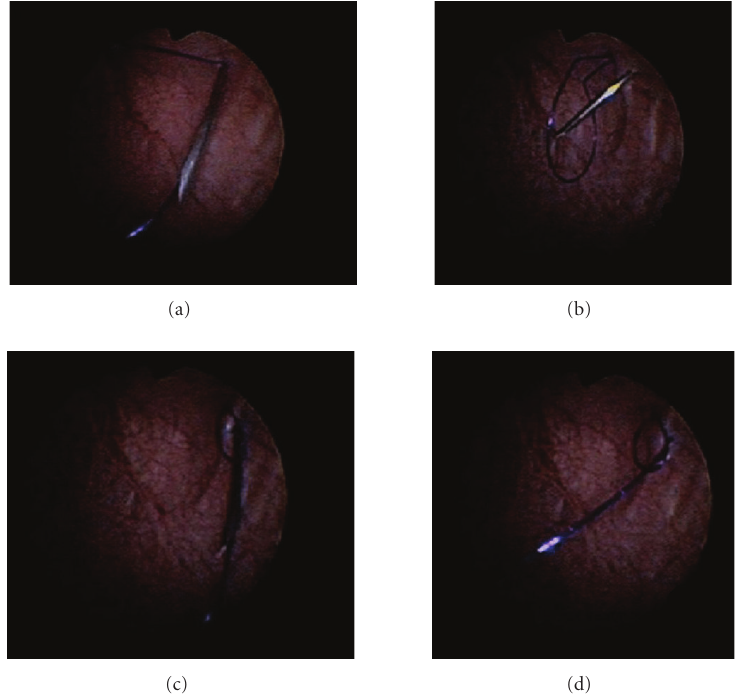
Figure 2: (a) Spinal needle has pushed suture into bladder creating pulling loop. (b) Spinal needle passed through pulling loop via an adjacent puncture. (c) With needle through pulling loop, one free end of the suture is passed through spinal needle and thus the pulling loop. (d) Removal of spinal needle results in suture being snared by pulling loop. Subsequent retraction of pulling loop creates through-and- through suture which can then be tied fixing bladder to abdominal wall.